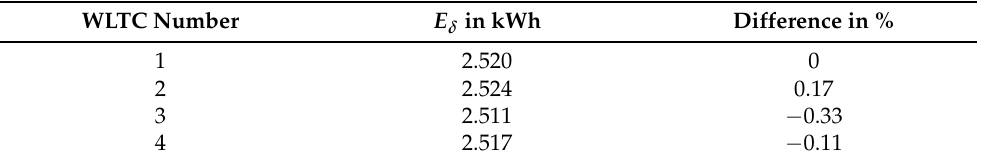
Table 2. E δ comparison of the measured WLTCs with the Kia.